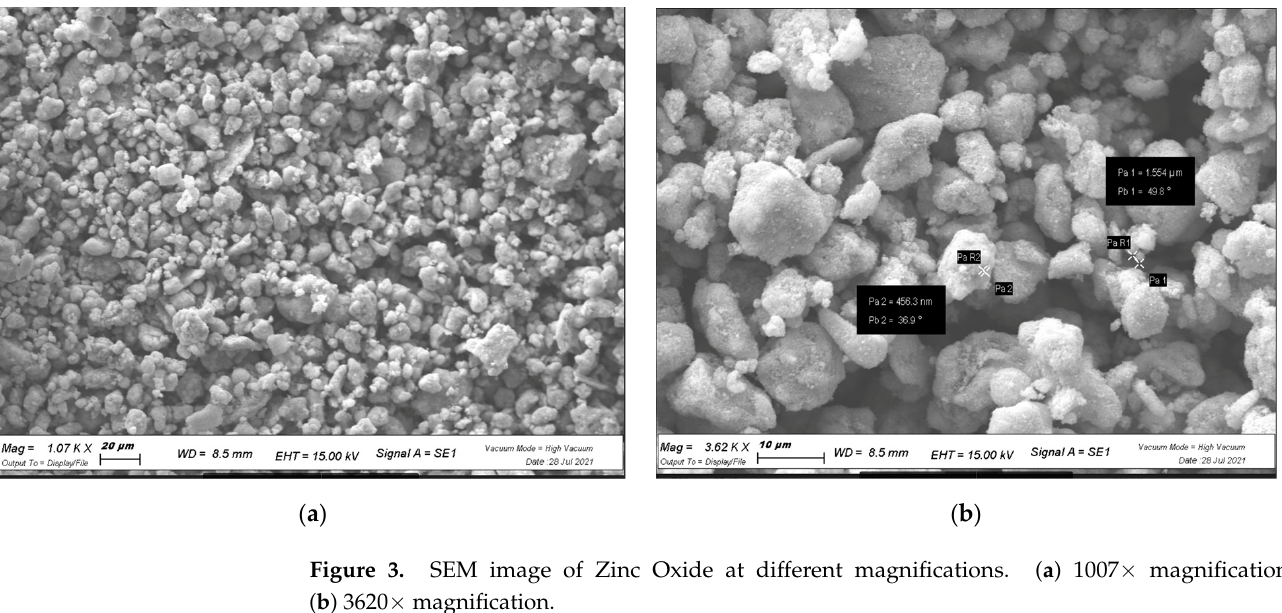
Figure 3. SEM image of Zinc Oxide at different magnifications. ( a ) 1007× magnification; ( b ) 3620× magnification.